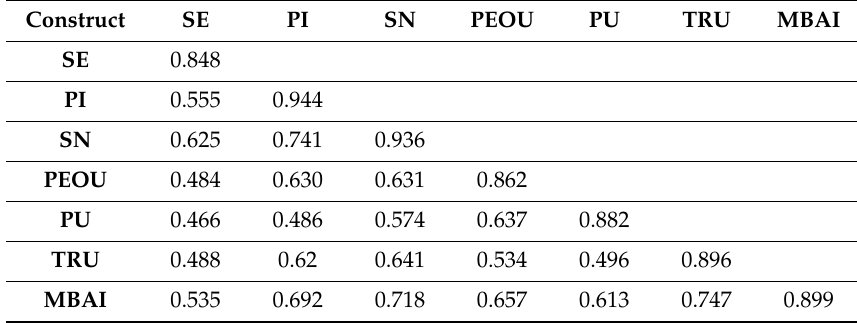
Table 6. Model Fit Indices.